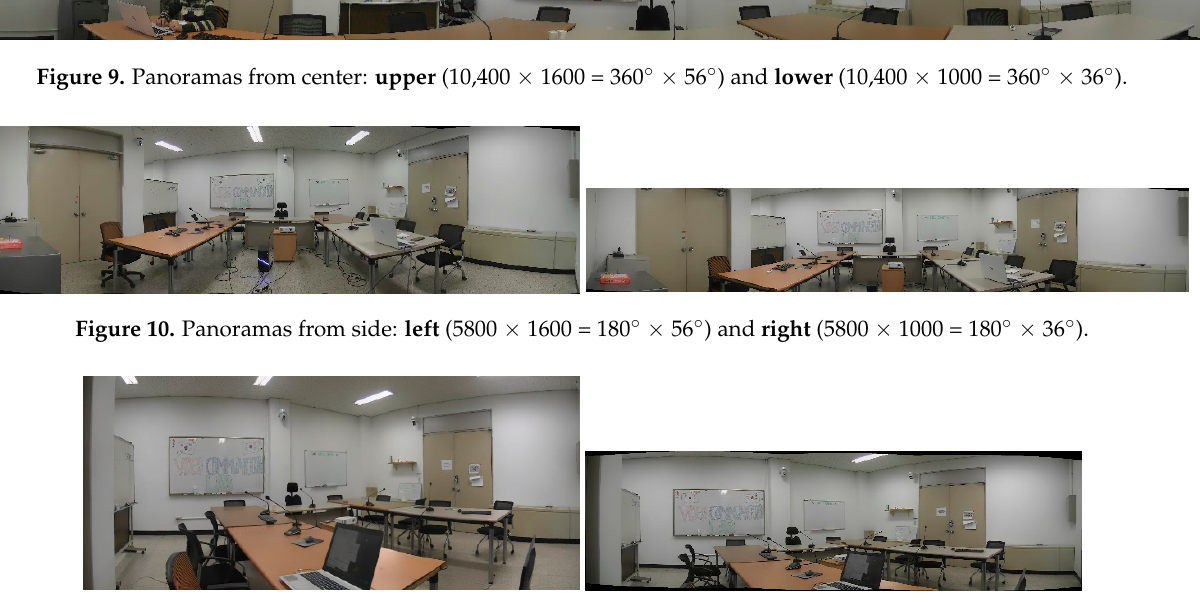
Figure 11. Panoramas from corner: left (3800 × 1600 = 90° × 56°) and right (3800 × 1000 = 90° × 36°).